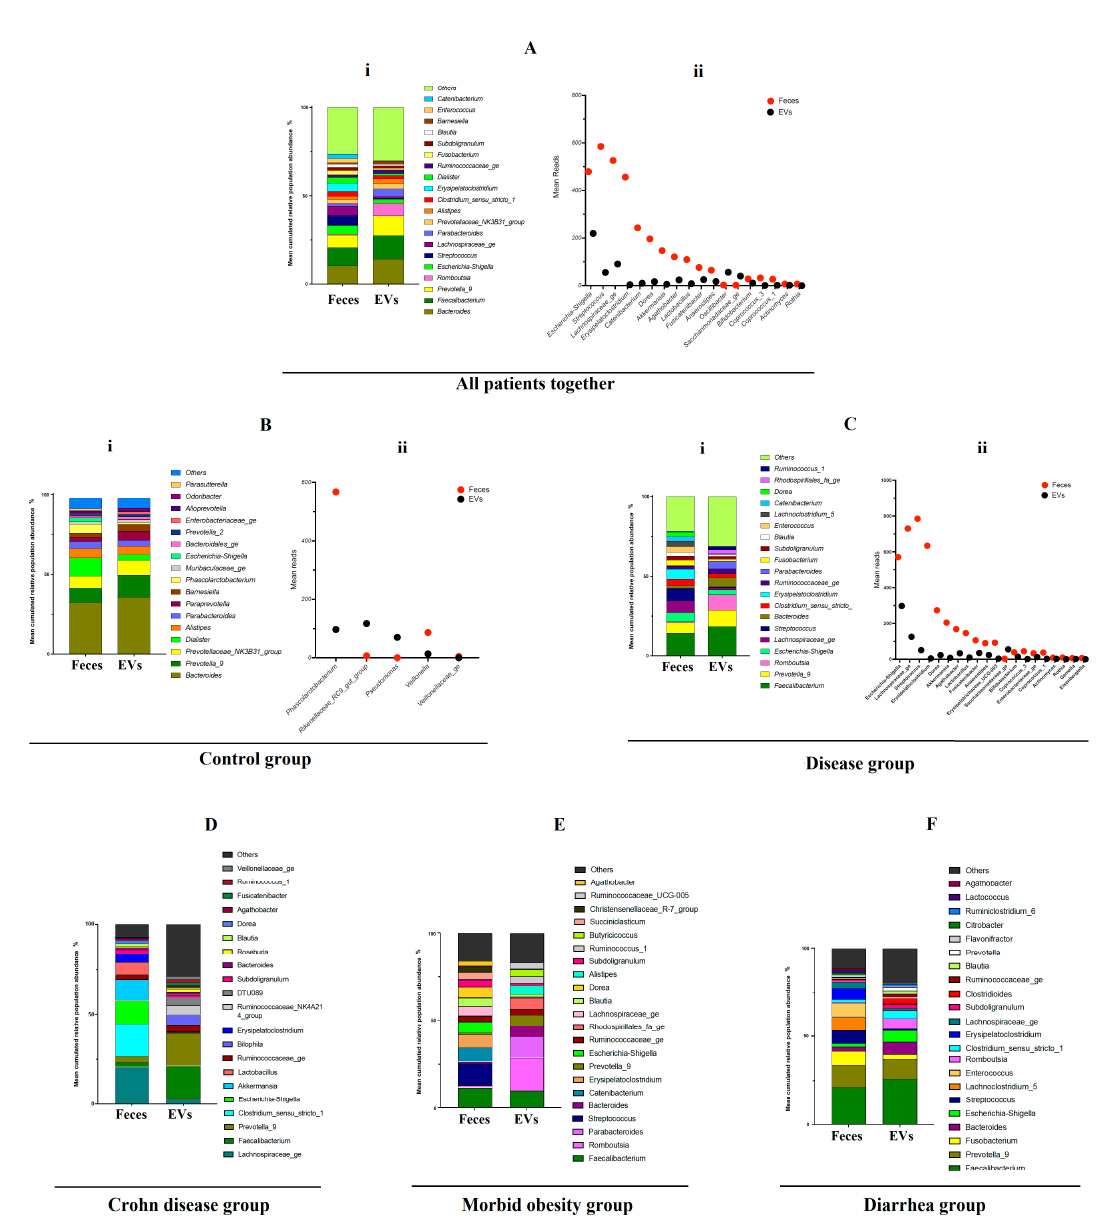
Figure 4. Relative abundance of bacterial genera in fecal microbiota and fecal-microbe-derived EVs. ( A ) All types of subjects (healthy controls and disease patients) were grouped in this analysis. ( B ) Only healthy subjects (n = 9) were considered for this analysis: namely, the control group. ( C ) Only disease patients (n = 23) were considered for this analysis, including diarrheic, morbidly obese and CD patients. ( D ) Only Crohn’s disease subjects (n = 4) were considered for this analysis. ( E ) Only morbid obese subjects (n = 9) were considered for this analysis. ( F ) Only diarrheic subjects (n = 10) were considered for this analysis. (i) Relative abundance of bacterial genera. Only genera with a relative abundance ≥ 1% were plotted. (ii) Box plot showing bacterial genera statistically different between fecal microbiota and fecal-microbe-derived EVs. Results of DESeq2 with Benjamini–Hochberg FDR